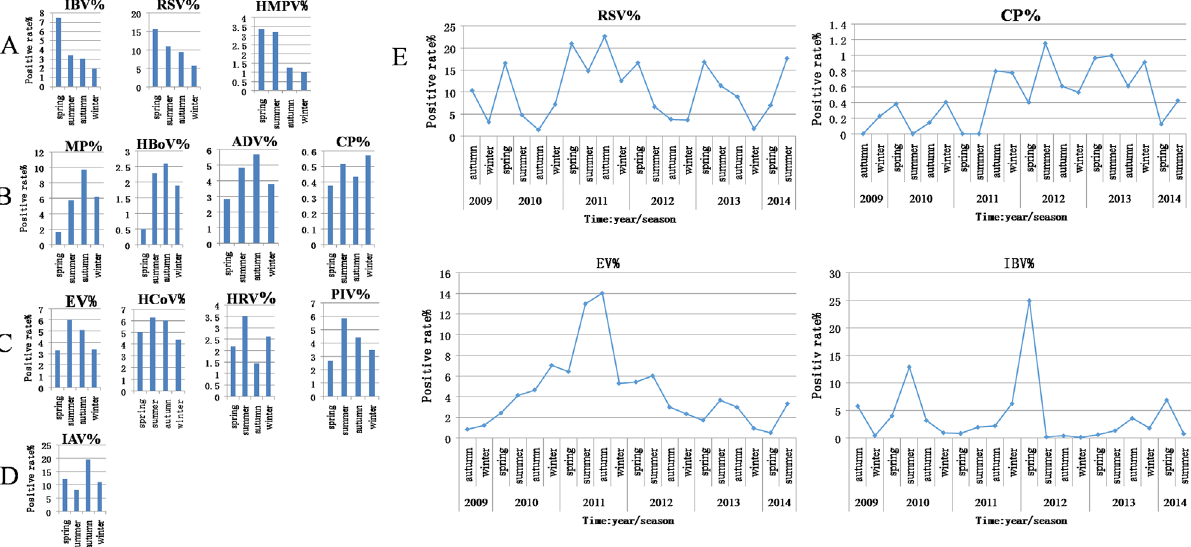
Fig 3. The seasonal prevalence patterns over five years. A, B, C, and D: the seasonal PDRs among 12 kinds of pathogens; E, contains the regular (upper row) and irregular (bottom row) seasonal PDR patterns between July 2009 and June